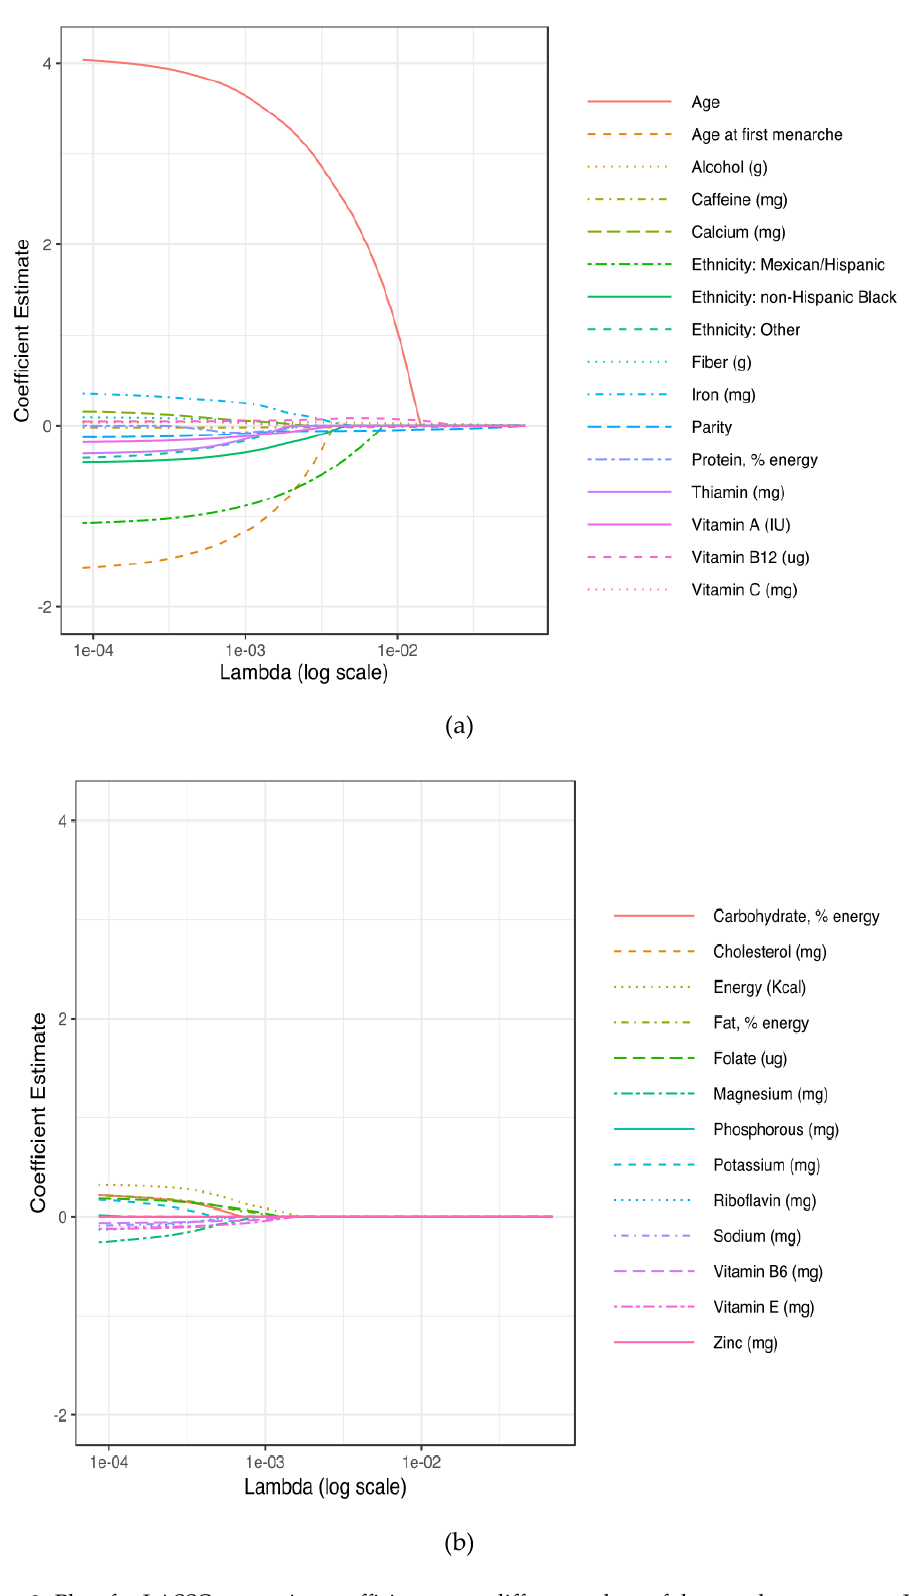
Figure 3. Plots for LASSO regression coefficients over different values of the penalty parameter. In (a) , data shown are the sixteen variables that remained in the model the longest as the penalty term increased; in (b) , data shown are the remaining variables in the model.